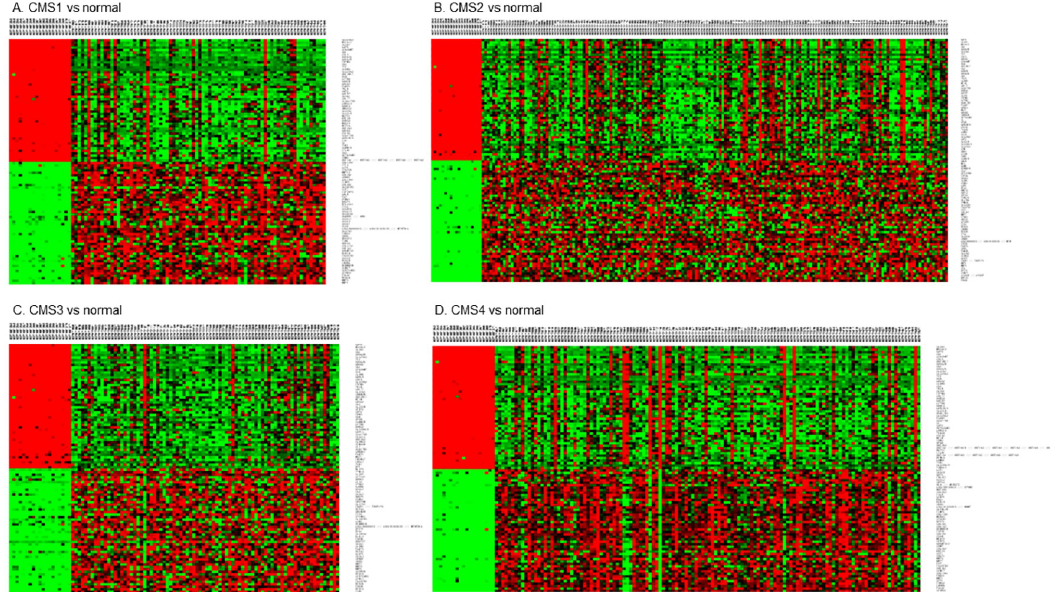
Fig 2. Heat maps visualization of the pattern of expression change for the top 50 differentially expressed genes. The upper row of each heat map consisted of the detailed configuration of the left 19 normal samples and corresponding CRC subtype samples. The right column was the 50 up-regulated and 50 down-regulated DEGs among each subtype vs normal samples, represented in red and blue respectively in the map. Software meV. (version 4.7, http://mev.tm4.org/) was used for heat map display.